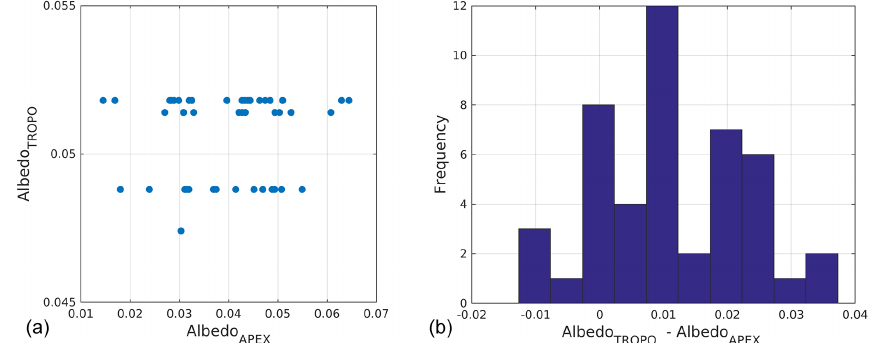
Figure 4. (a) Scatter plot and (b) histogram for the comparison between TROPOMI albedo and APEX albedo, resampled at TROPOMI resolution, for the ensemble of the four APEX data